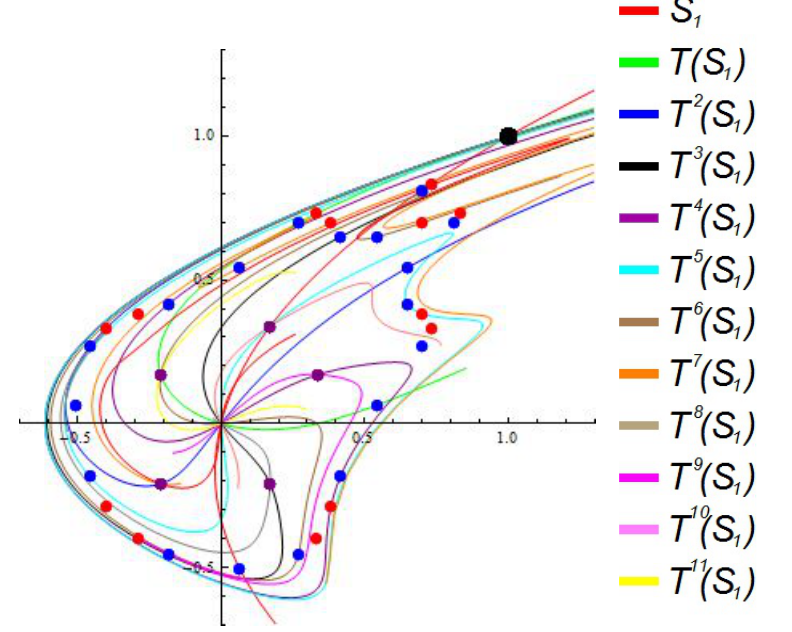
Figure 9. Period 5—Purple, 13—Red and 18—Blue for α = 0.5 (see Table